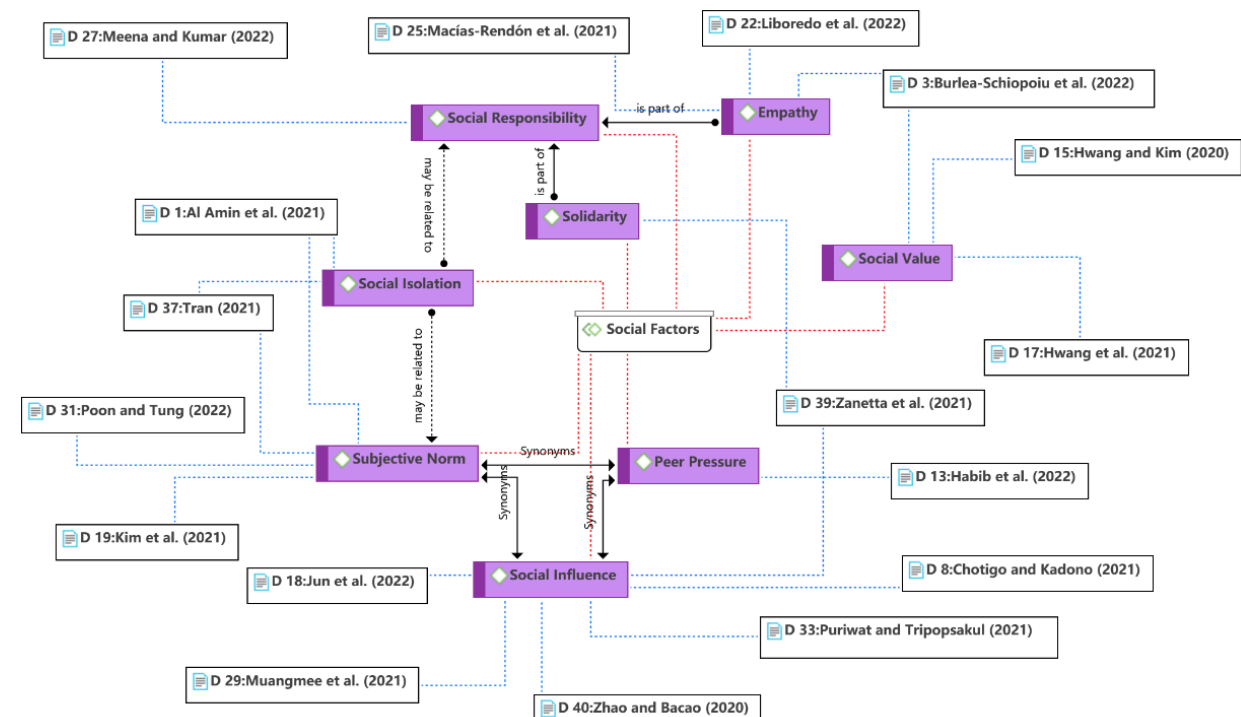
Figure 11. Theme 7: social factors [6,9,13,23,35,37,39,41 – 43,48,52,54 – 56,58,61].